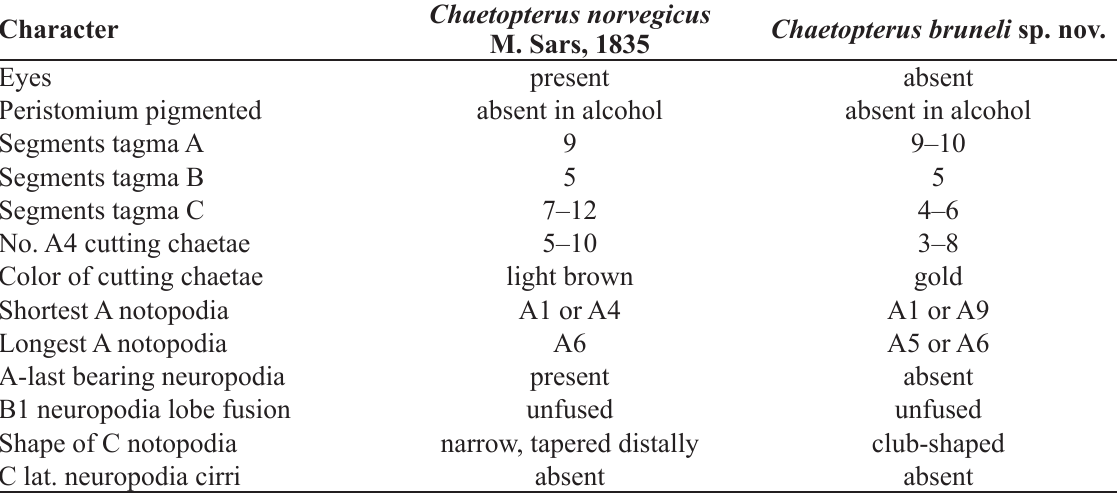
Table 1. Comparative morphological data summary of Chaetopterus norvegicus M. Sars, 1835 and C. bruneli sp. nov. Segment numbers follow conventional counting within tagmata A, B and C for Chaetopteridae Audouin & Milne-Edwards, 1833. A-last = the last chaetiger in tagma A; lat. =